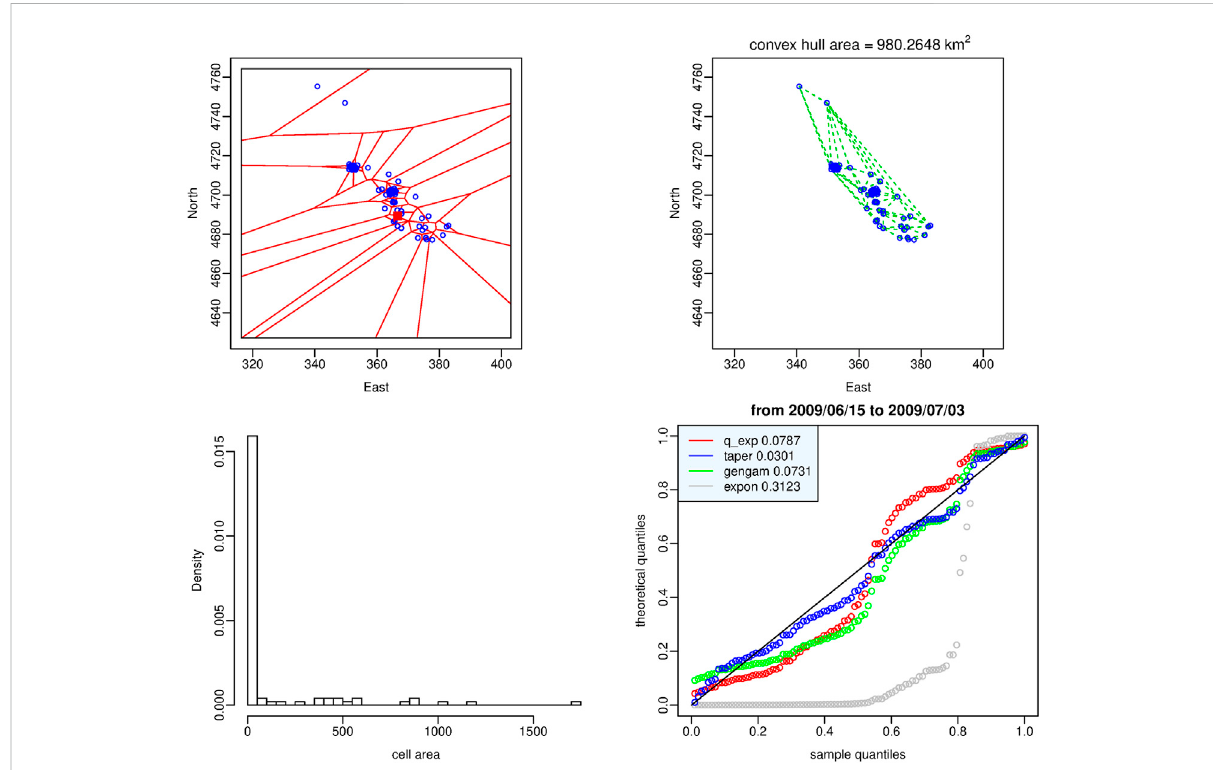
FIGURE 5 Dataset of the time window in which the tapered Pareto distribution provides the best fi t. Top: Voronoi tessellation (left-hand panel) and Delaunay triangulation (right-hand panel). Bottom: histogram of the cell areas (left-hand panel) and Q-Q plot of the four probability distributions (right-hand panel). Red square indicates the epicenter of L ’ Aquila